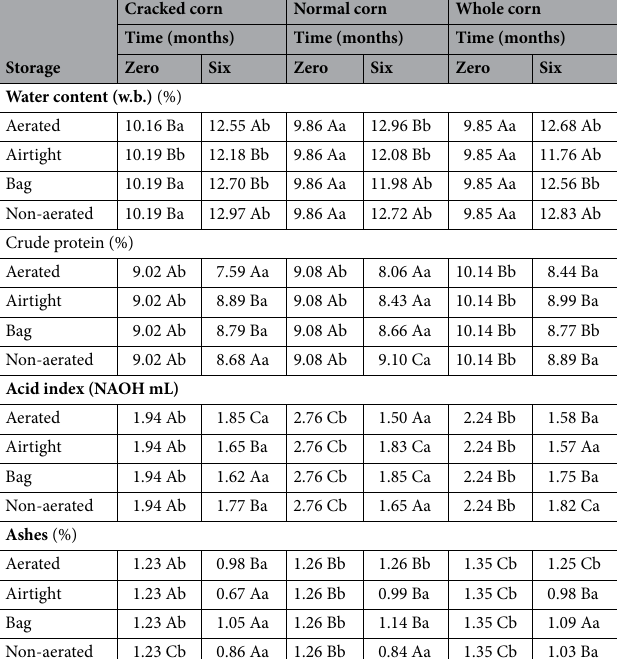
Table 4. Physical–chemical quality of corn kernels stored under different systems and durations. *Means followed by the capital letter in the line for each storage time and lowercase in the column for each storage form, do not differ at 5%